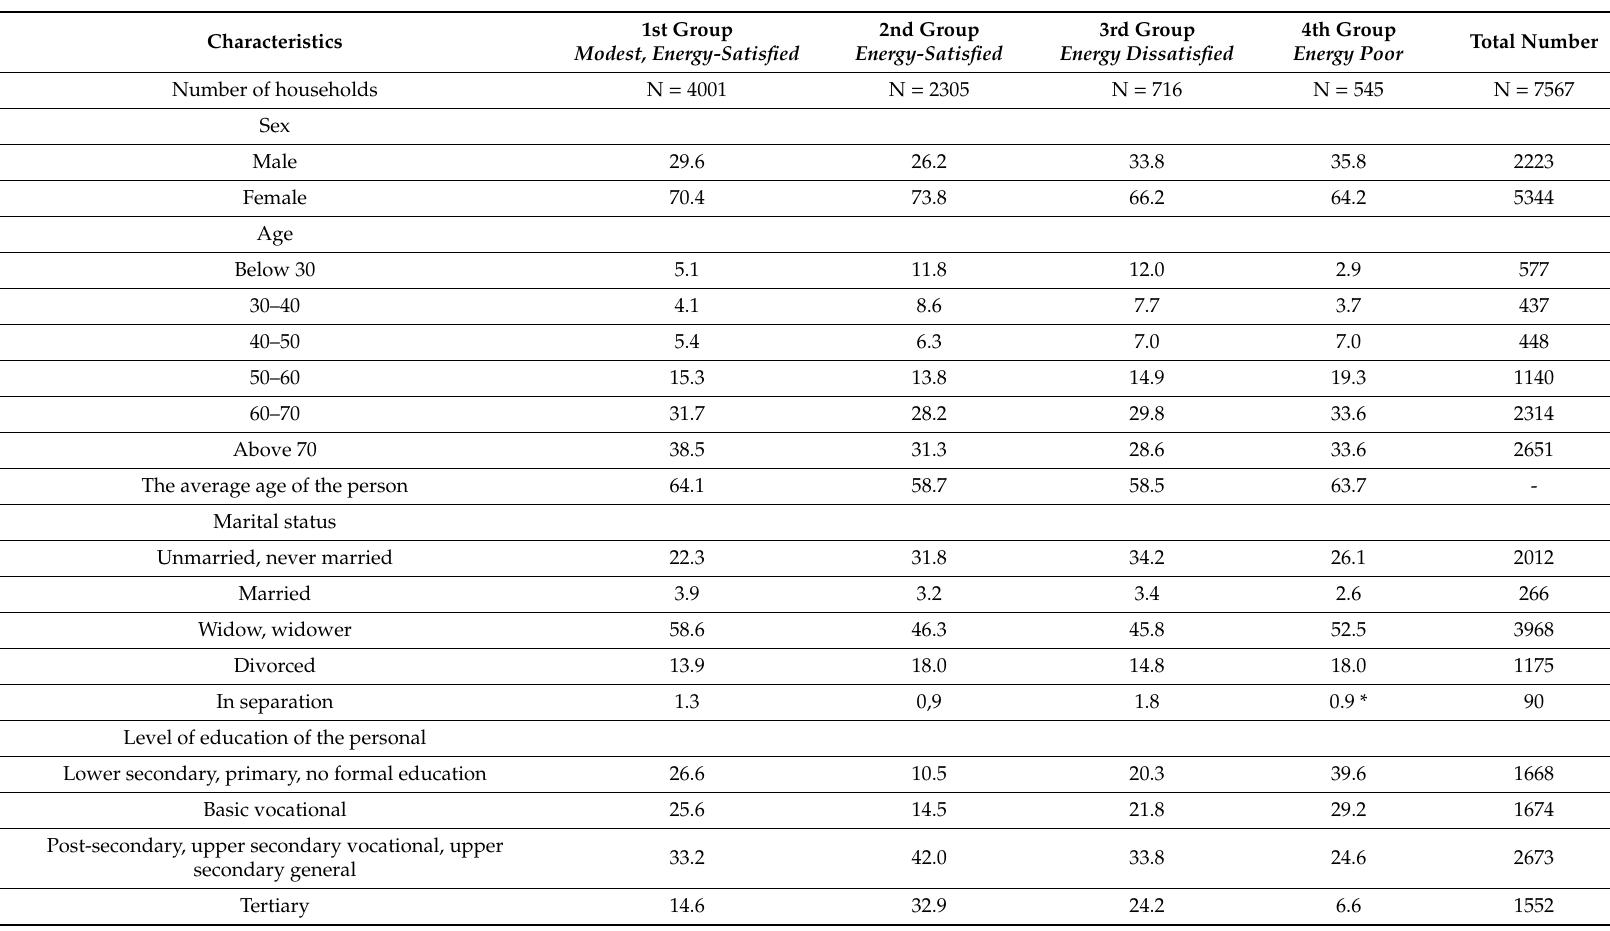
Table 6. Economic and socio-demographic characteristics of the types of one-person households in Poland in 2016 (as a percentage of a given cluster).